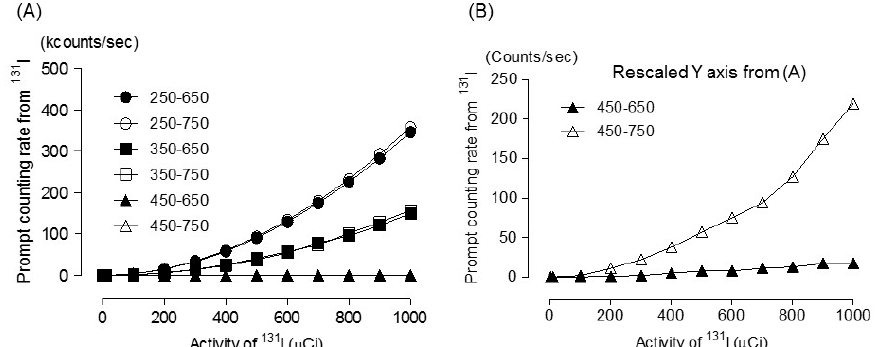
Figure 2. ( A ) Prompt emission counting rate due to 131 I within various energy windows. ( B ) Rescaled Y axis from Figure 2A. The value between “450 and 650 keV” and “450 and 750 keV” was not discernible in the scale of Kcounts/sec in Figure 2A. Therefore, we rescaled the Y-axis for the visibility of “450–650 keV” and “450–750 keV” in Figure 2B.